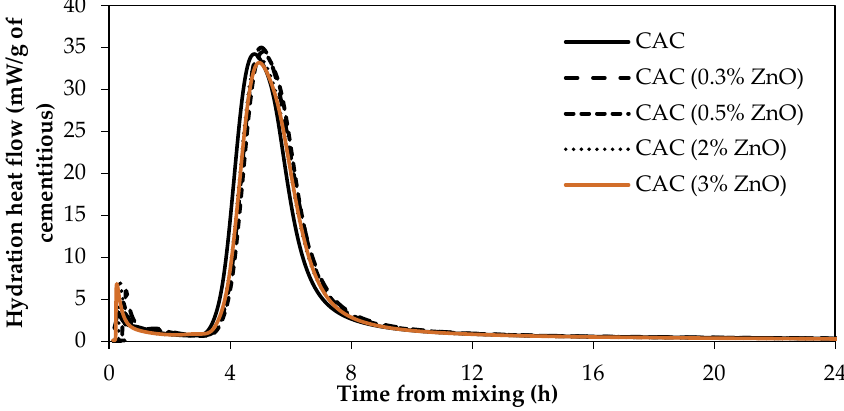
Figure 7. Heat of hydration of CAC with and without ZnO addition.